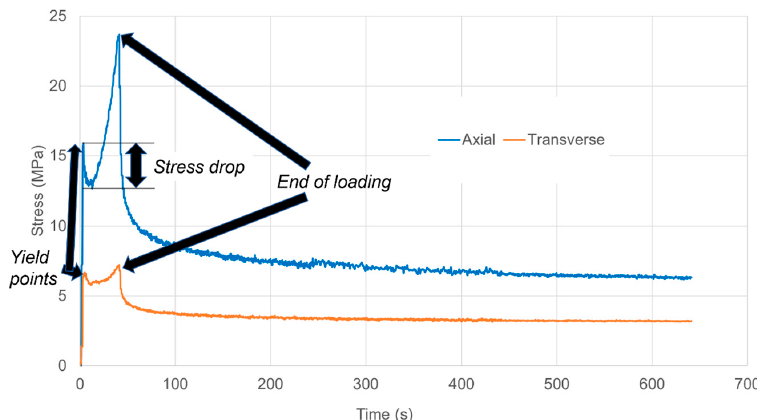
Figure 3. Stress relaxation in planar extension after straining at an octahedral strain rate of 0.010 s − 1 , showing yield points, subsequent drop in stress followed by strain hardening and stress relaxation.